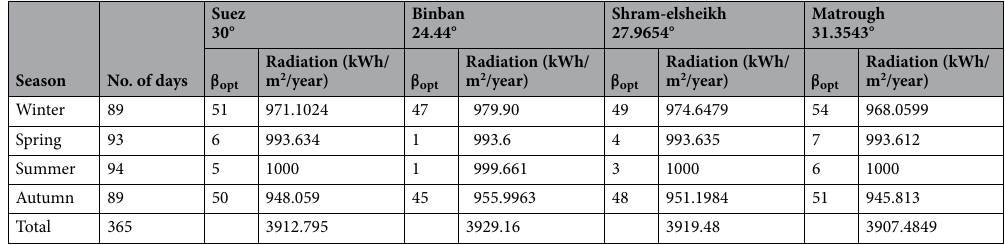
Table 3. The optimal angle and solar radiation for Case 3.